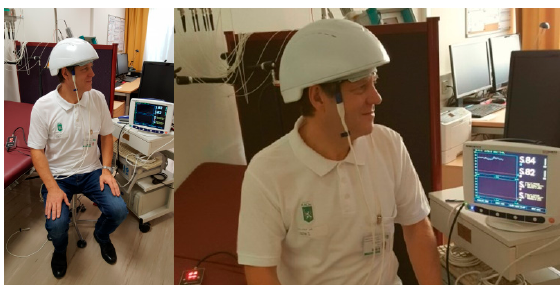
Figure 1. First measurement with the innovative LED (light emitting diode) photobiomodulation